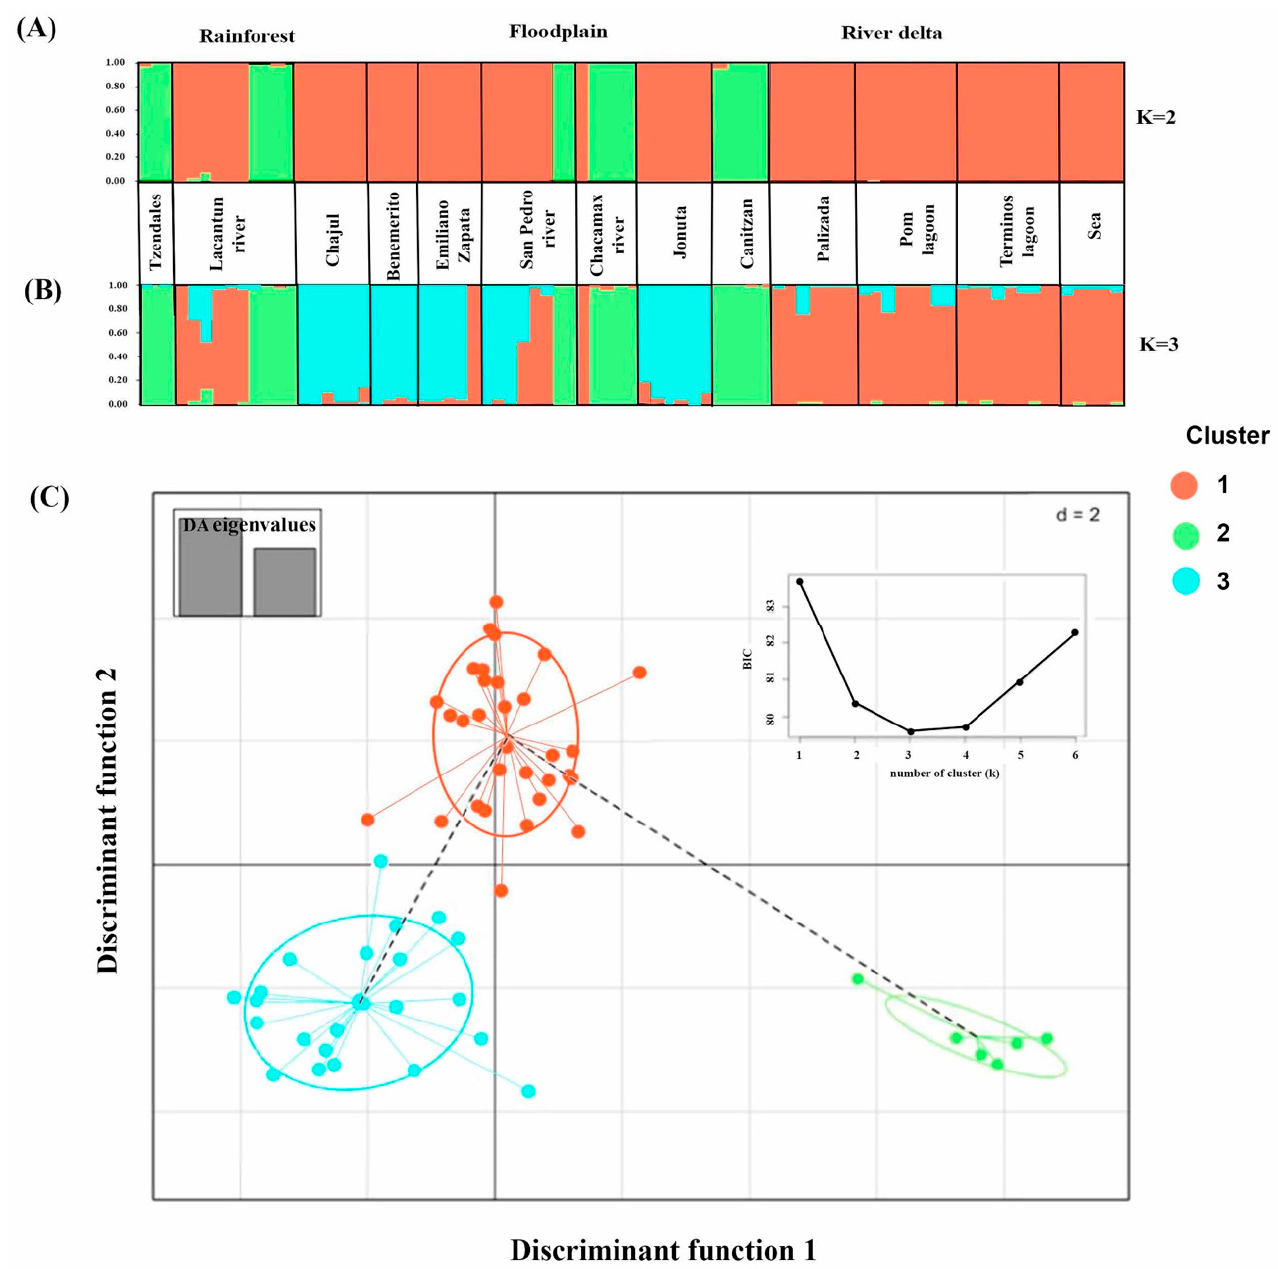
Figure 3. Assessment of population genetic structure by Bayesian cluster analysis and DAPC based on the microsatellite data. Bayesian Analysis was inferred at K = 2 based on locus data. Each single vertical line represents an individual and its proportional membership probability among the K clusters. ( A ) K = 2; ( B ) K = 3. ( C ) Scatterplots of the discriminant analysis of principal components of the microsatellite data, using find.clusters , for three zones. The axes represent the first two linear discriminants (LD). Each circle represents a cluster and each dot represents an individual.